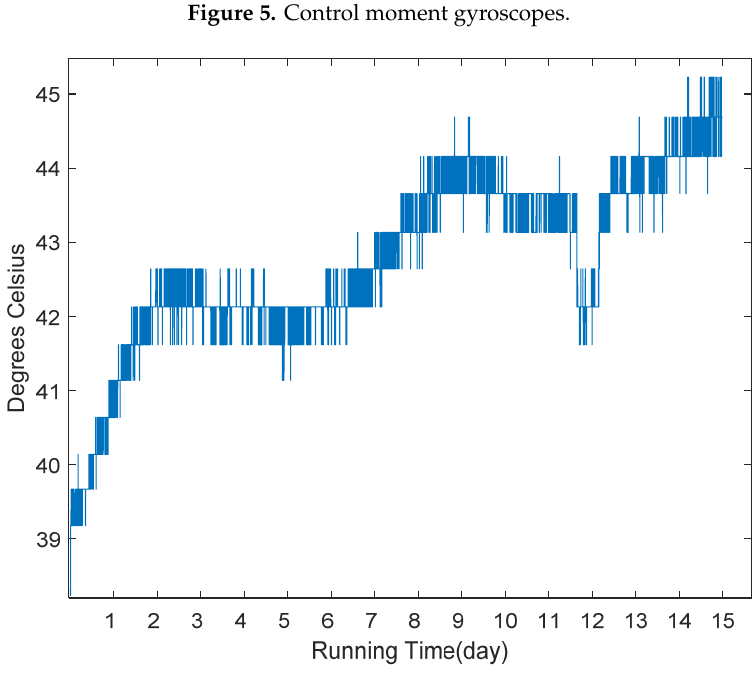
Figure 6. The raw data. Figure 6. The raw